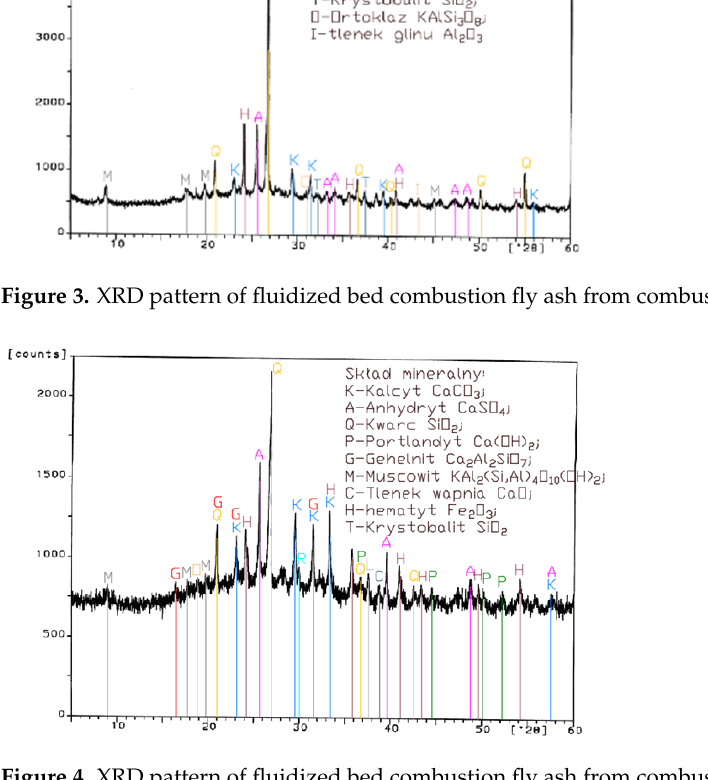
Figure 4. XRD pattern of fluidized bed combustion fly ash from combustion of hard coal (FBC III). Differences in the phase composition are characteristic and depend on the type of ashes used (FBC v siliceous fly ashes). Analysis of diffractograms of siliceous fly ashes